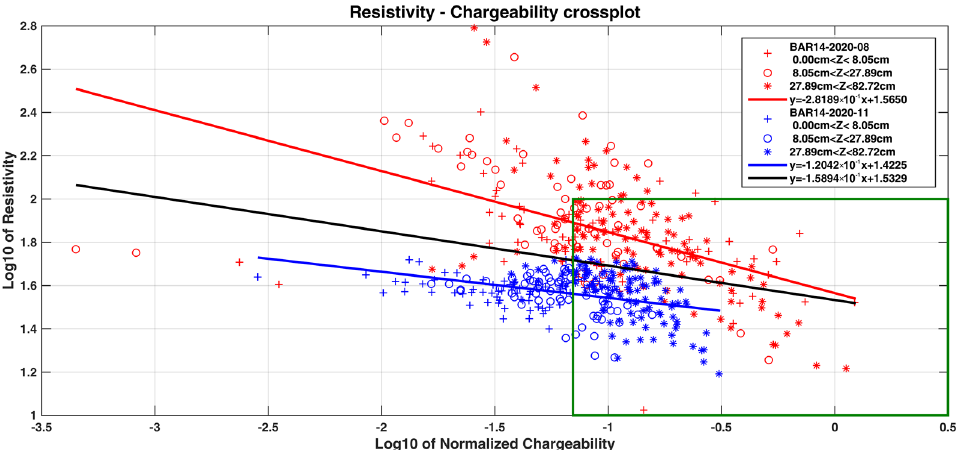
Figure 5. Log 10 –log 10 diagram of normalized chargeability and resistivity values from the geoelec- trical sections data of site #14 acquired at wet (blue) and dry (red) periods. The crosses, circles and stars correspond to the three depth zones, respectively. Blue and red lines correspond to the linear regression of wet and dry period data, respectively, while the black one corresponds to the total data from both periods.